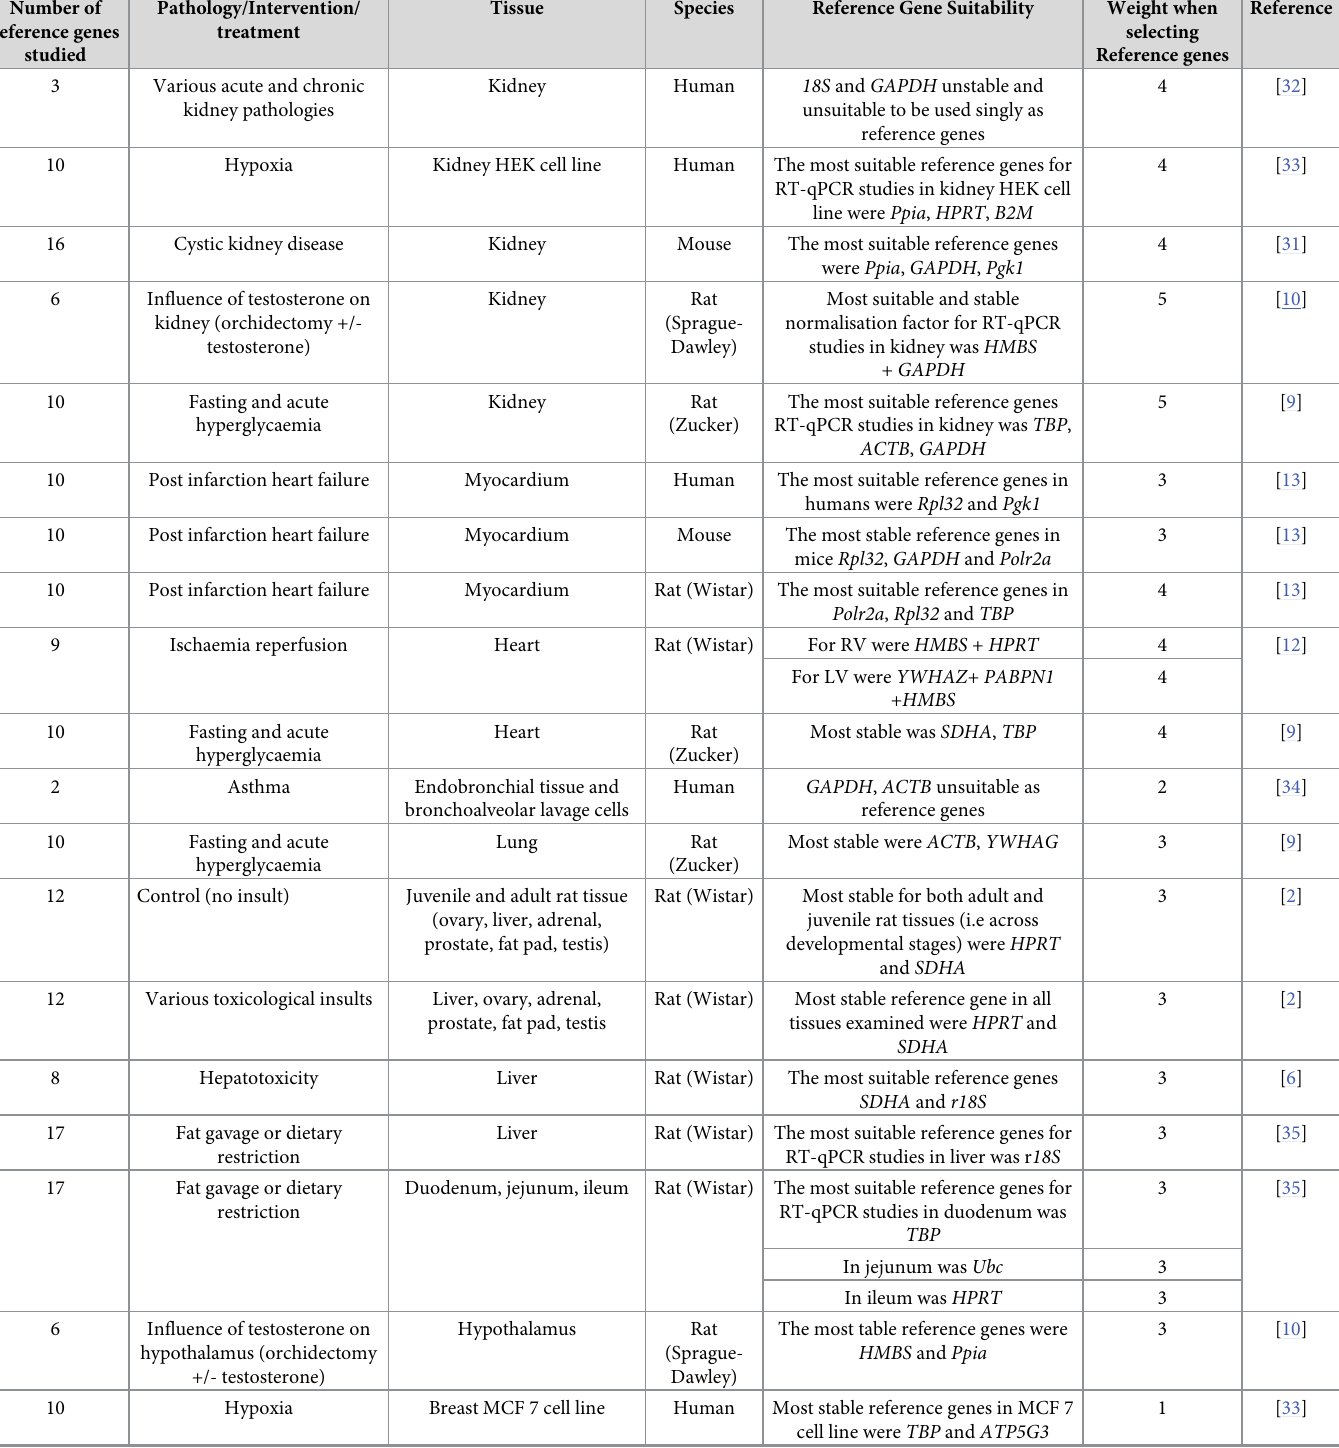
Table 1. Reference gene evaluation